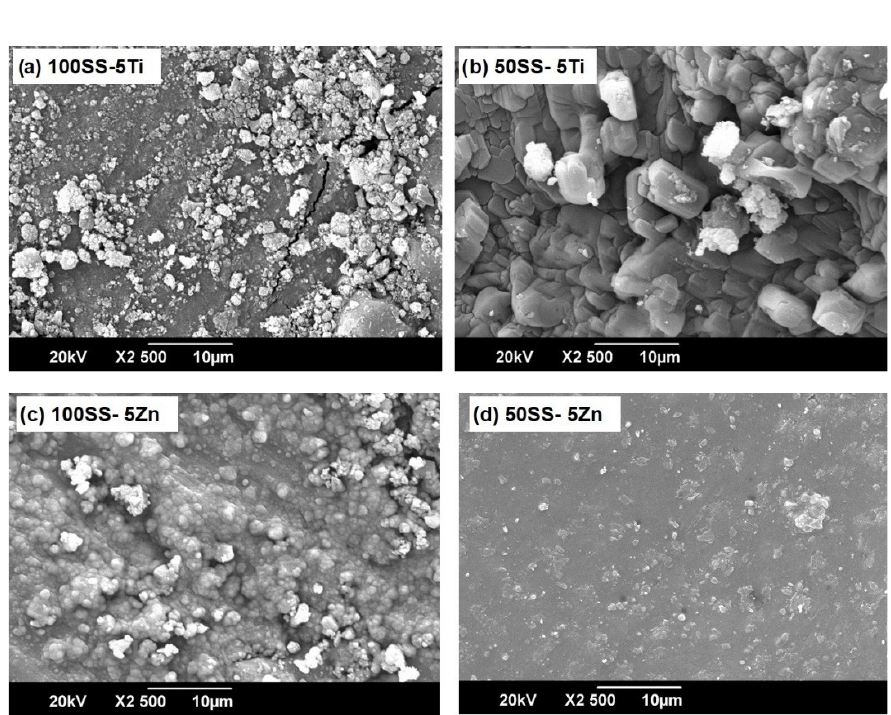
Figure 9. SEM images of composites with ( a , b ) 5% of TiO 2 and ( c , d ) 5% of